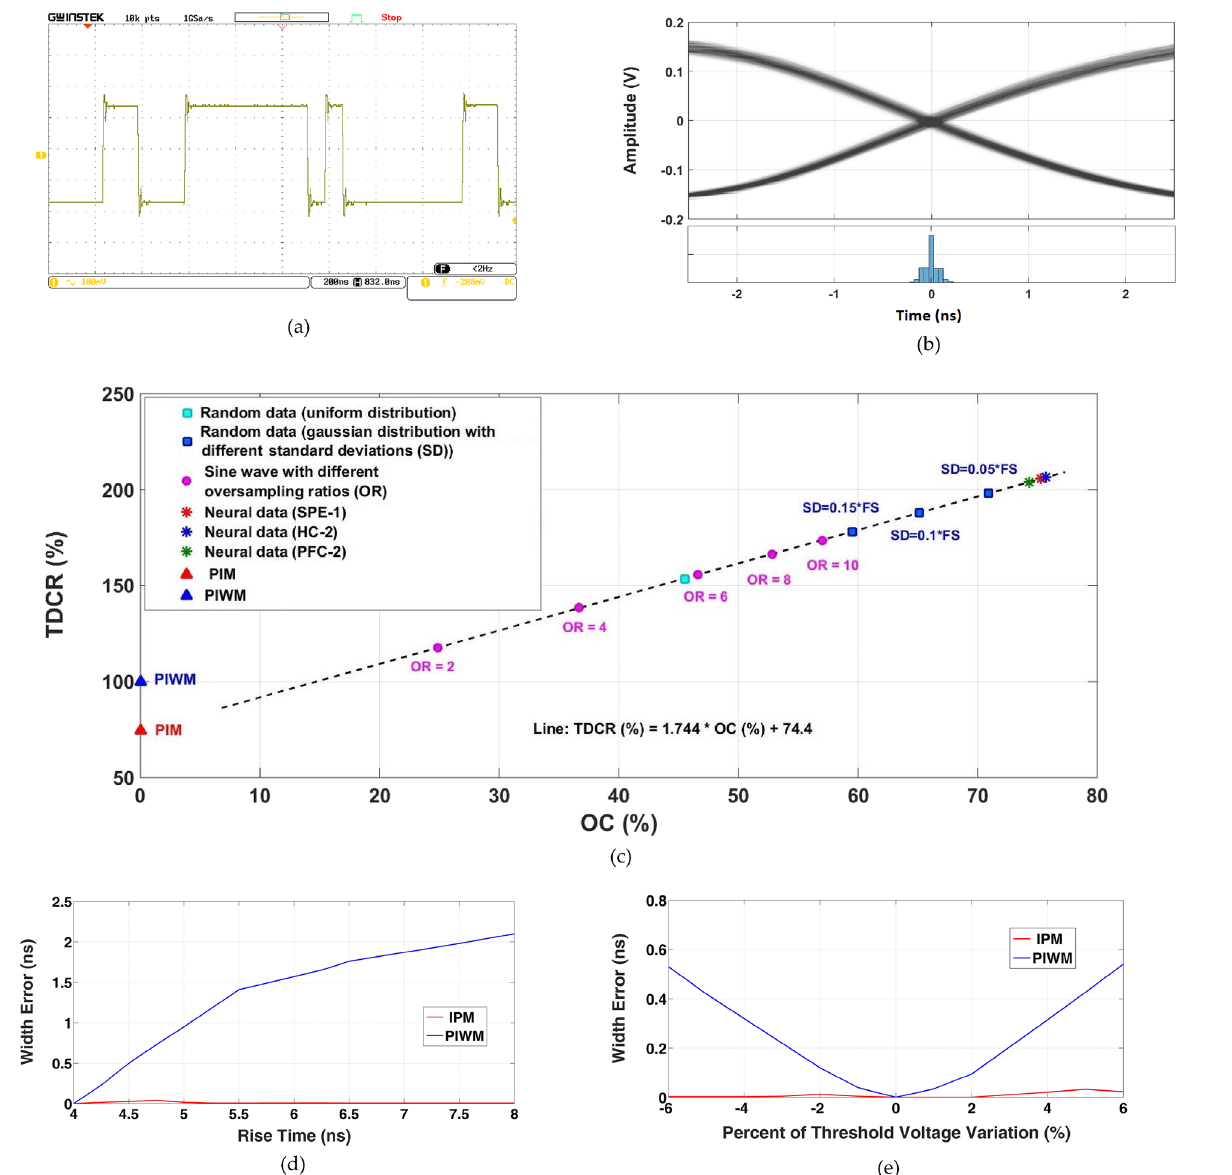
Figure 8. Experimental verification and characterization of the key properties of the IPM scheme and comparison with other anisochronous schemes. ( a ) oscilloscope screen shot showing an IPM-encoded waveform, ( b ) aligned rising and falling edges for 3000 IPM pulses on the receiver side of the experimental setup as well as the associated pulse-width error histogram, ( c ) the TDCR-OC plot for the IPM scheme in the case of sinewaves (with oversampling ratios ranging from 2 to 10), random data with uniform and Gaussian distributions (for the Gaussian case, standard deviations of 5%, 10%, and 15% of the full-scale amplitude), and three different intra-cortical neural signals. It should be noted that all the same signals were encoded on the same setup with PIM and PIWM approaches, the results of which are exactly on the same spots designated using triangular symbols, ( d ) effect of rise time variation on the width error for IPM and PIWM pulses (fall time is fixed and equal to 4 ns), and ( e ) effect of threshold voltage variation on width error for IPM and PIWM